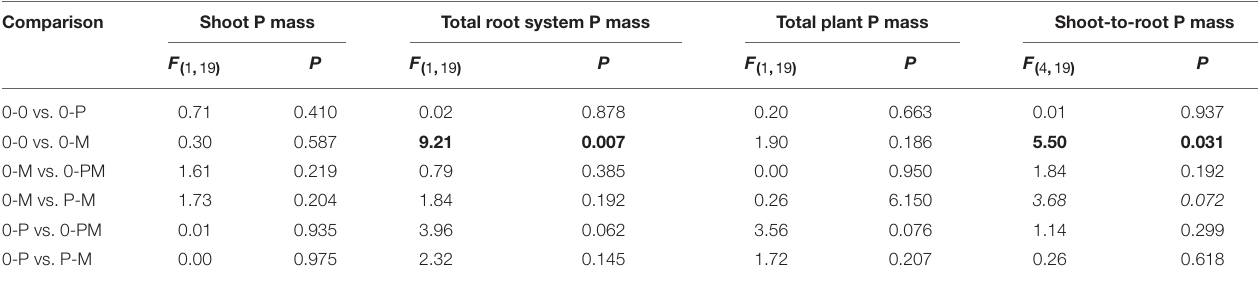
TABLE 3 | F - and P -values of GLM contrasts showing treatment effects on the total shoot P mass, total root P mass, total plant P mass, and shoot-to-root P mass of Triticum aestivum . Comparison Shoot P mass Total root system P mass Total plant P mass Shoot-to-root P